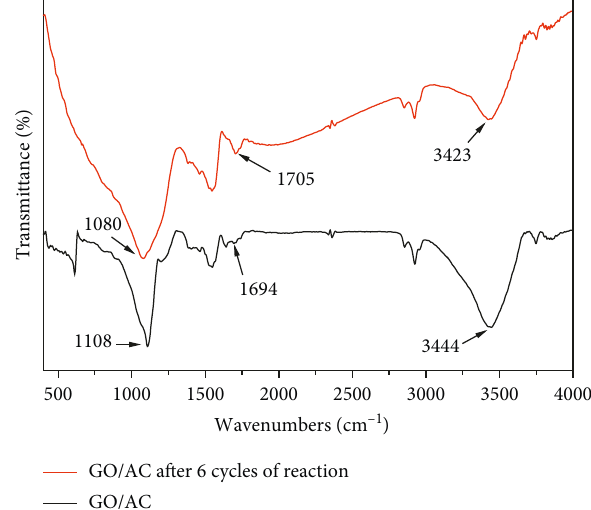
Figure 6: FT-IR spectra of GO/AC and GO/AC after 6 reaction